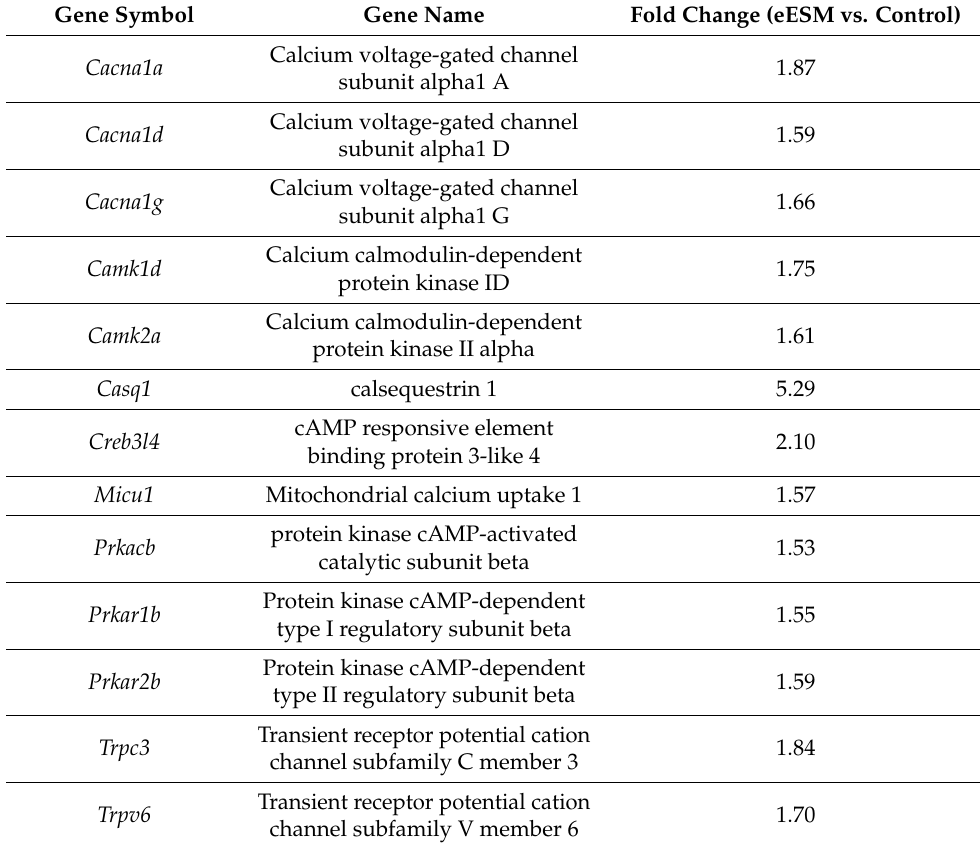
Table 3. Major gene lists of “Calcium